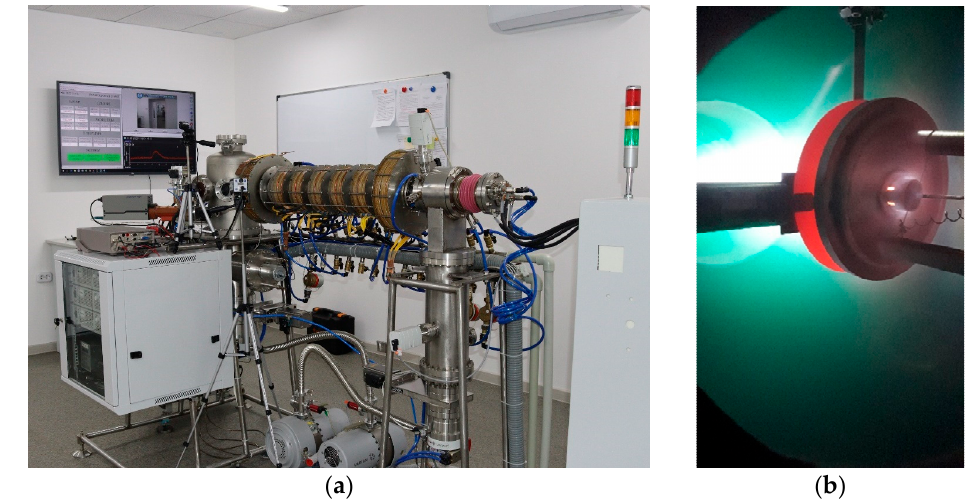
Figure 2. Plasma beam installation ( a ) and the back side of the sample ( b ) in the chamber.